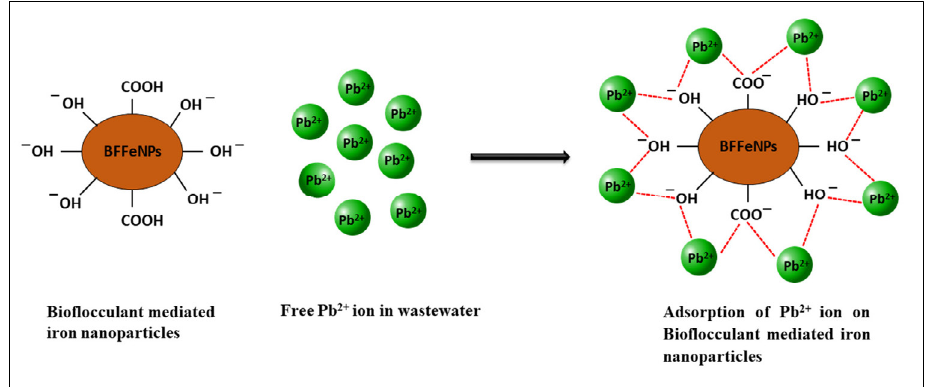
Fig. 9. Schematic representation of the possible mechanism of Pb (II) ion adsorption on